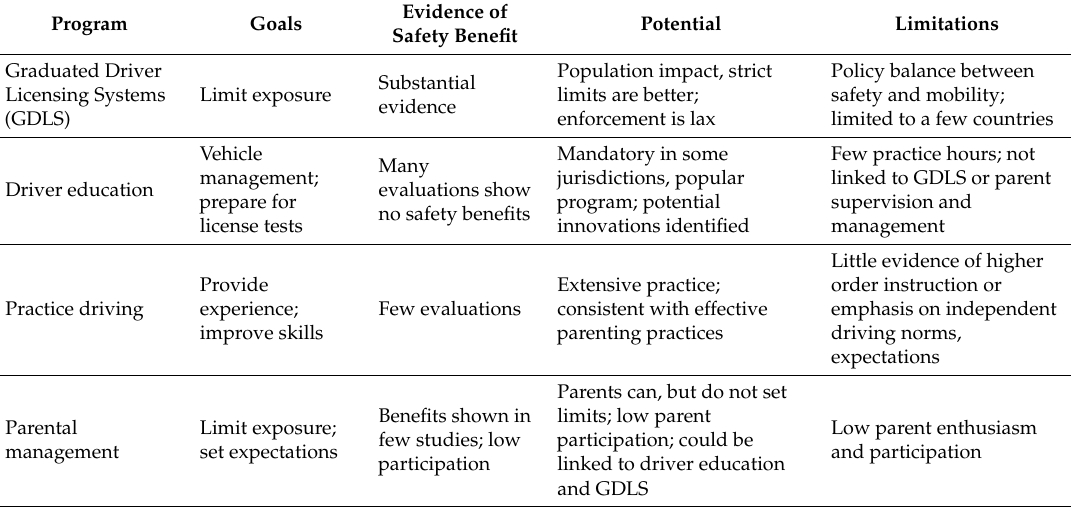
Table 1. Novice teen driving safety programs: do they improve safety? Evidence, potential and